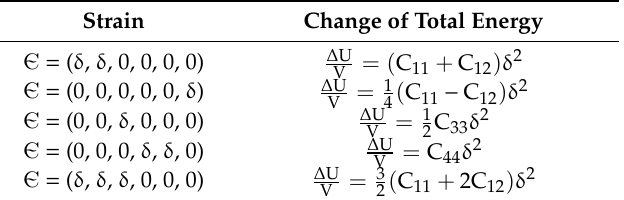
Table 4. The relationship between the strains ( δ ) and the total energy changes ( ∆ U) of HCP metal. Strain Change of Total